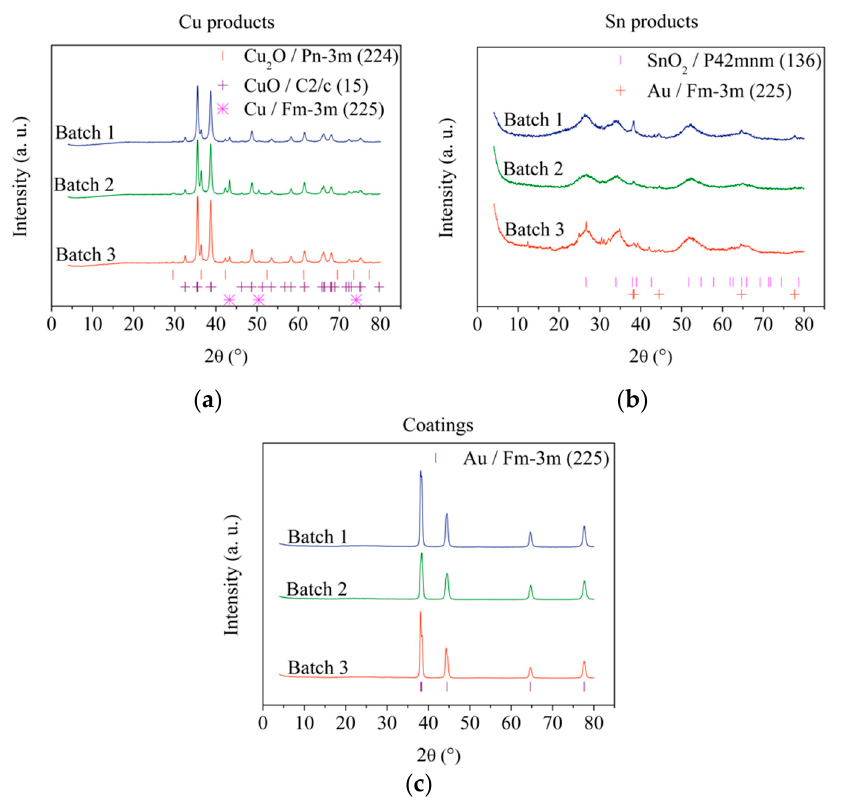
Figure 4. X-ray diffraction patterns of ( a ) Cu products (JCPDS files: 04-0836, 05-0667 and 48-1548 for Cu, Cu 2 O and CuO, respectively), ( b ) Sn products (JCPDS file: 41-1445 for SnO 2 ) and ( c ) Au coatings recovered from batches 1, 2 and 3 (JCPDS file: 04-0836 for Au).